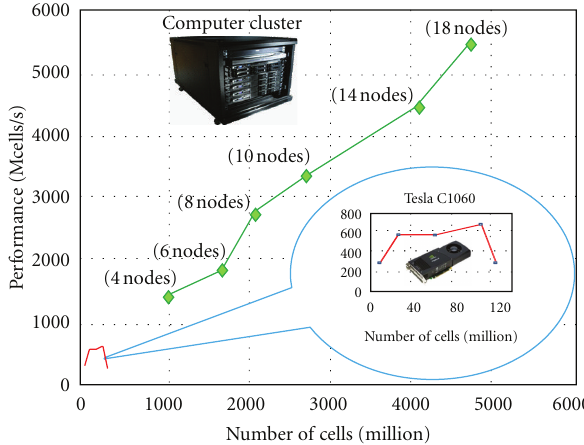
Figure 8: Performance of parallel FDTD enhanced by using SSE instruction set on a cluster platform and comparison to the GPU acceleration.